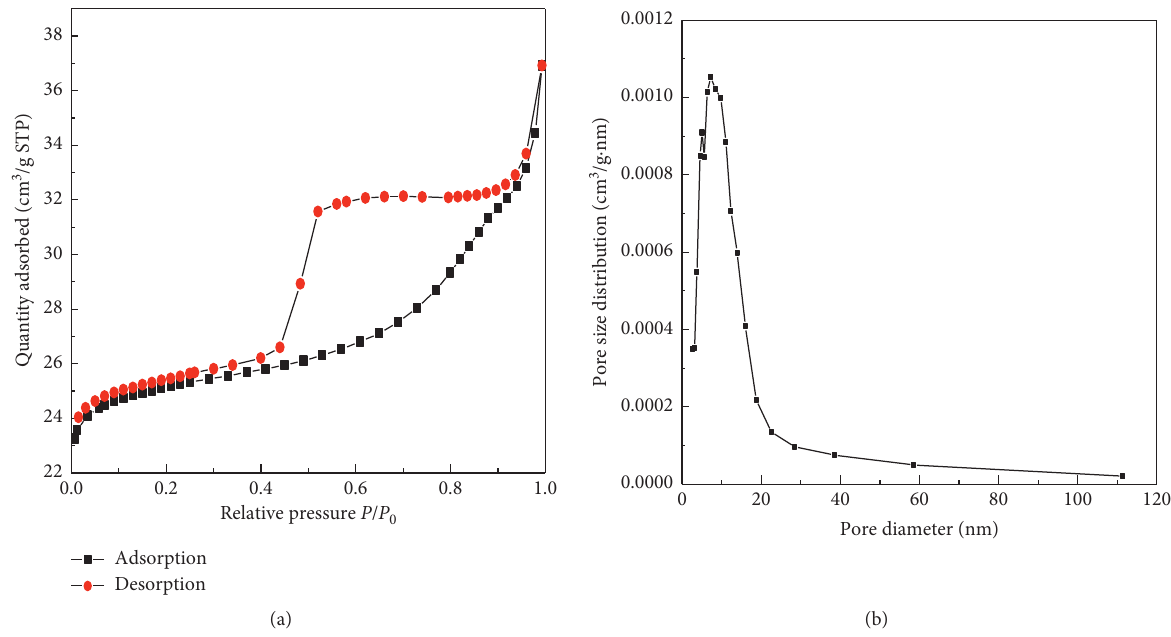
Figure 6: (a) Nitrogen adsorption-desorption isotherms of EMRZ; (b) pore size distribution of EMRZ (synthesis conditions: reaction temperature, 100 ° C; reaction time, 1.5h; initial Si/Al ratio,